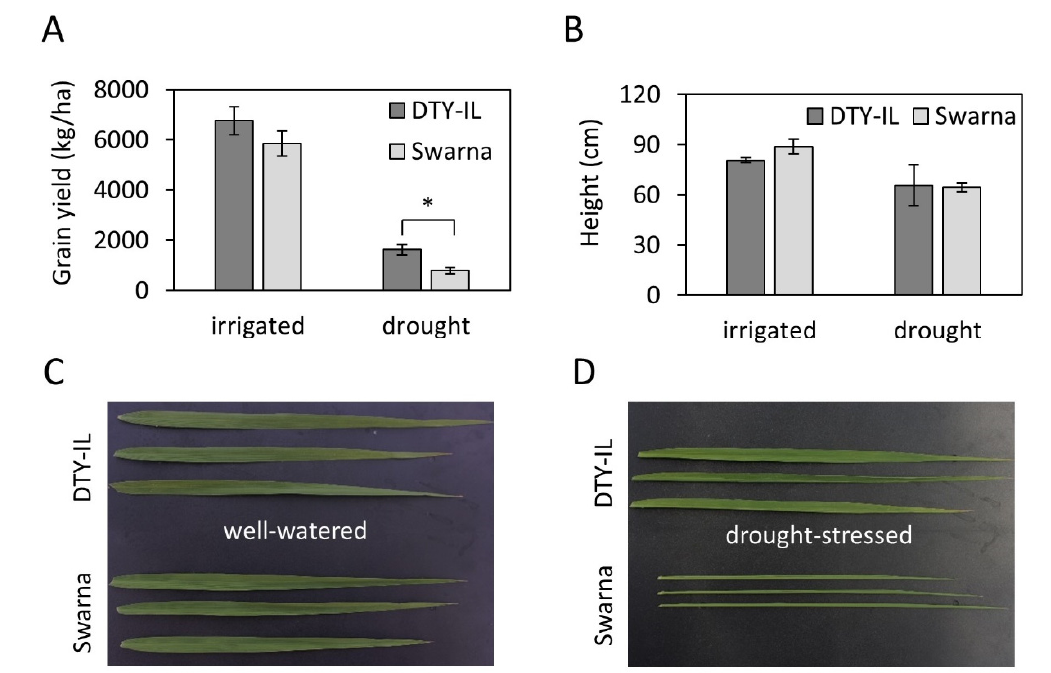
Figure 1. The effect of reproductive stage drought on yield, height and flag-leaf morphology. The average grain yield ( A ) and plant height ( B ) across the 2014 and 2015 dry season (DS) field trial of DTY-Il and Swarna under irrigated and drought condition ( N = 2–9 ). Flag-leaf phenotypes of the DTY-IL and Swarna under well-watered conditions ( C ) and the leaf-rolling phenotype during drought-stress ( D ) under controlled greenhouse conditions. The asterisks (*) indicates a significant difference (Student’s t test, * p < 0.01).